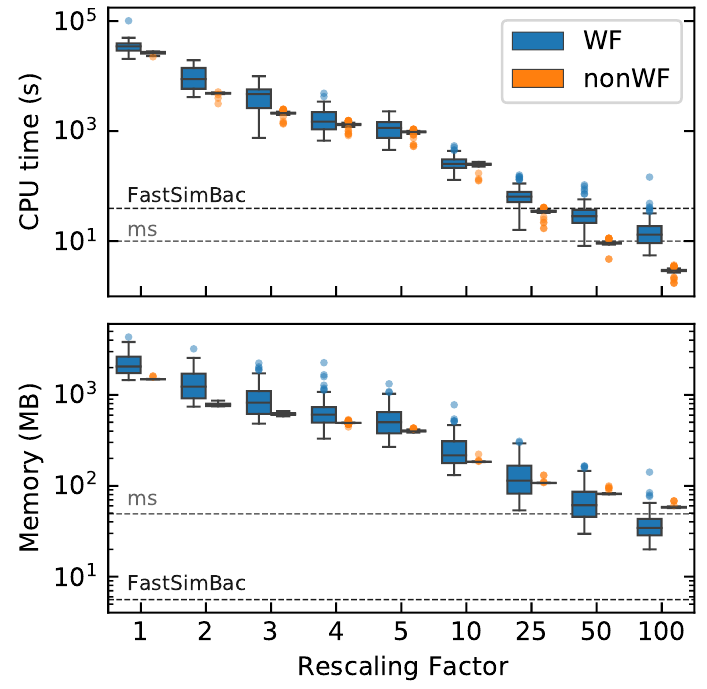
Figure 1 – Distribution of CPU time and peak memory usage for different rescaling fac- tors. For comparison with backward simulators, the dashed lines represent the average times for FastSimBac ( 54s) and ms ( 14s). Rescaling does not apply to backward simu- ∼ ∼ 5 lators. Note the log scale on the y axis; 10 seconds is about 28 hours. Parameters used 10 − 9 ; Ne = 140k; 20000 generations. There : chromosome size : 2Mb; µ = ρ = 1 . 53 ×